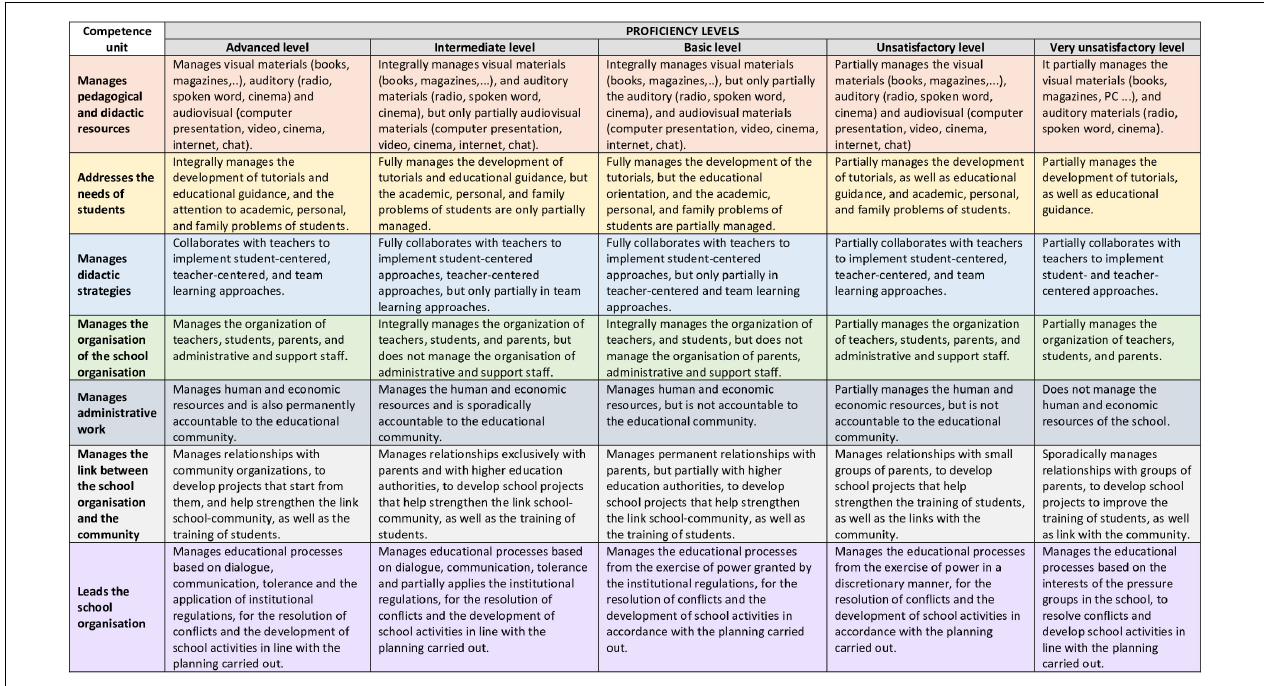
FIGURE 1 | Competence units and proficiency levels of distributed leadership competencies’ framework. Adapted from Mejía Capaza (2015).